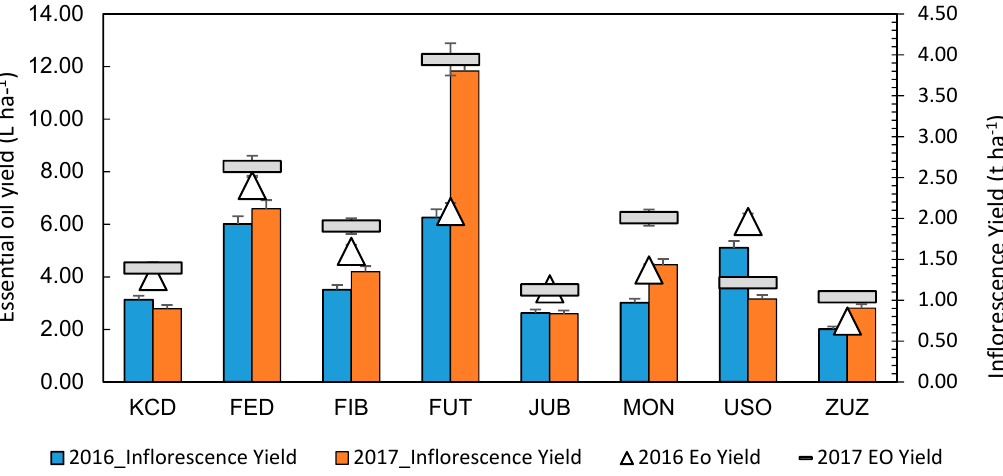
Figure 8. Inflorescence yield and EO yield of the hemp cultivars studied. Data are means, error bars are standard deviations. (KCD = KC Dora; FED = Fedora 17; FIB = Fibrol; FUT = Futura 75; JUB = Jubileu; MON = Monoica; USO = Uso-31; ZUZ = Zuzana).